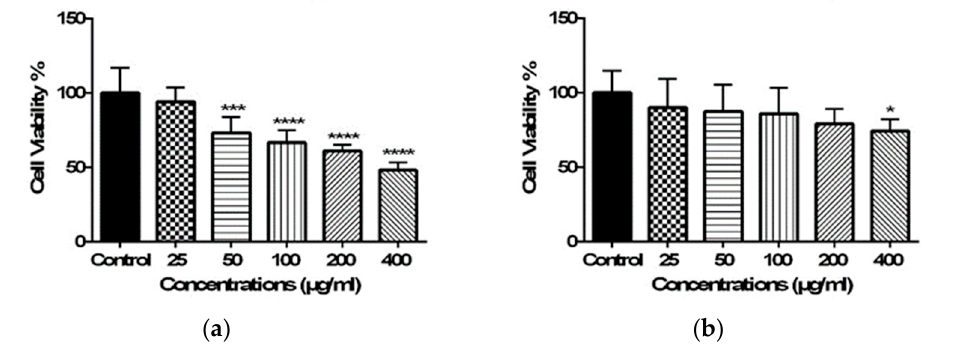
Figure 2. Cytotoxic effects of compound 7 on cell viability of A549 ( a ) and CCD-19Lu ( b ) cell lines. The results are the means of three independent experiments. The error bars represent the standard deviations (( n = 8), P > 0.05 not significant, * P < 0.05, ** P < 0.01, *** P < 0.001 and **** P < 0.0001 compared to the control